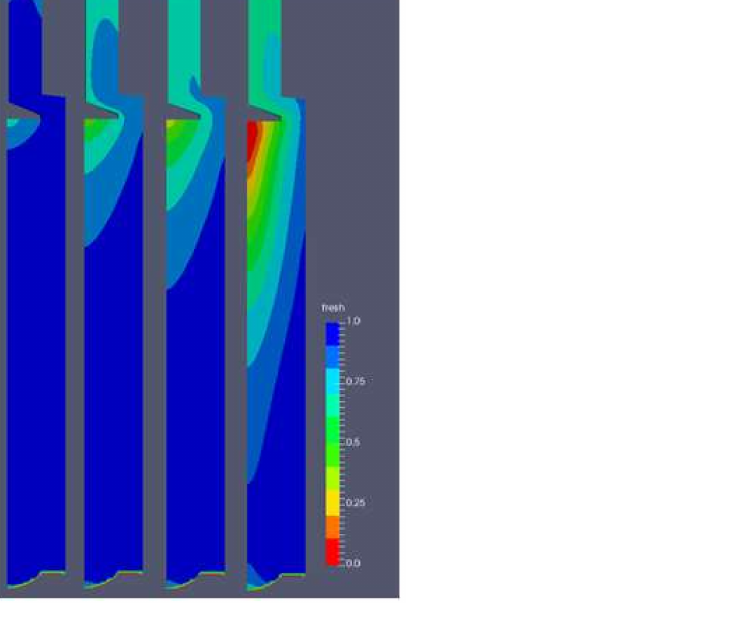
Figure 6. Fresh air propagation for the moment CA = 200 ◦ for the loads of 25%, 50%, 75%, and 100%, from left to right. The depicted contours represent fresh air concentration (fresh air mass [kg]/total mass [kg]).